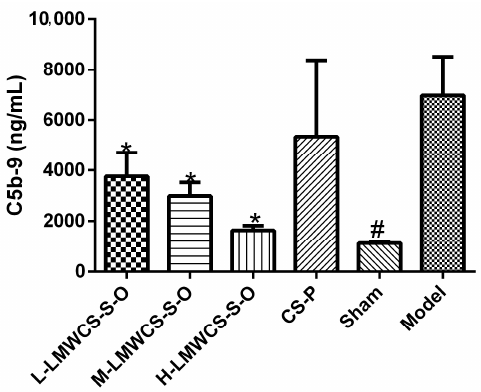
Figure 8. C5b-9 levels of all mice administered with LMWCS-S-O and CS-P. The L-LMWCS-S-O, M-LMWCS-S-O and H-LMWCS-S-O groups were administered with 50, 150 and 450 mg/kg of LMWCS-S-O, respectively. The CS-P group was administered with 150 mg/kg of CS-P. The sham and model groups were administered with saline. Bar graphs present n ≥ 5. * p < 0.05 vs. the model; # p < 0.05 vs. the model.